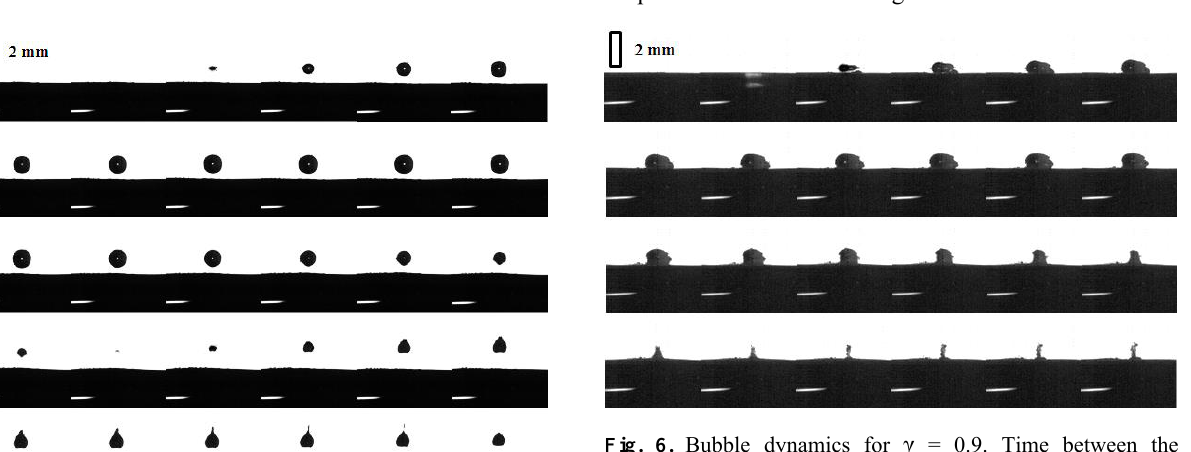
Fig. 6. Bubble dynamics for γ = 0.9. Time between the individual frames is 5.9 µs.